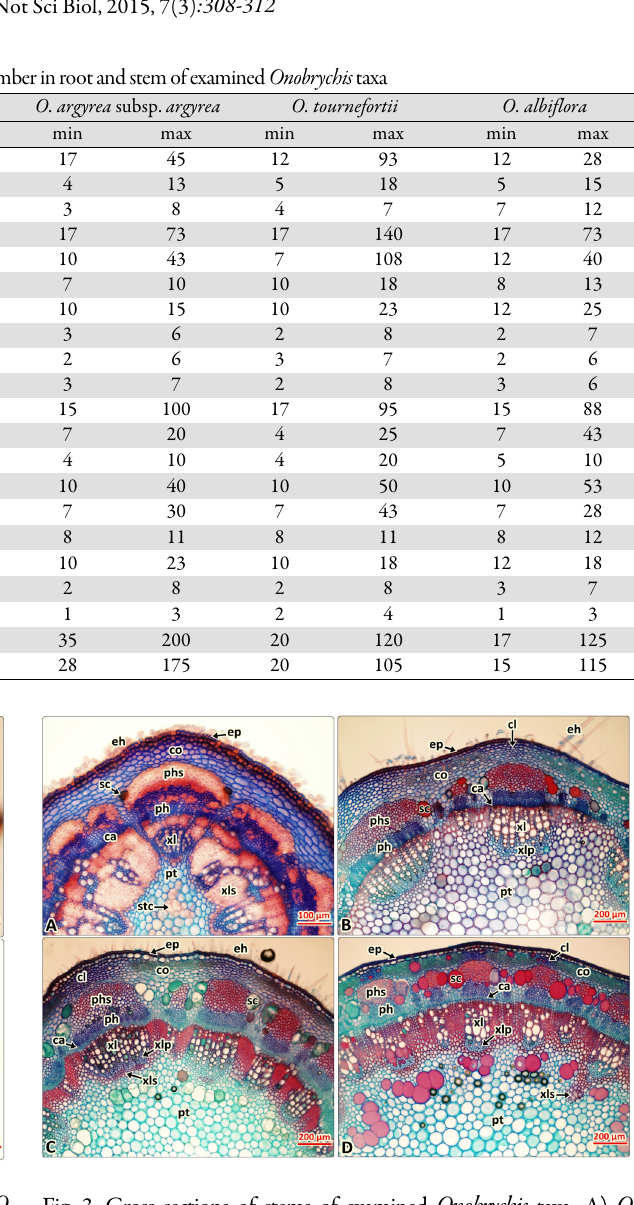
Fig. 2. Cross sections of roots of examined Onobrychis taxa: A) O. Fig. 3. Cross sections of stems of examined Onobrychis taxa: A)